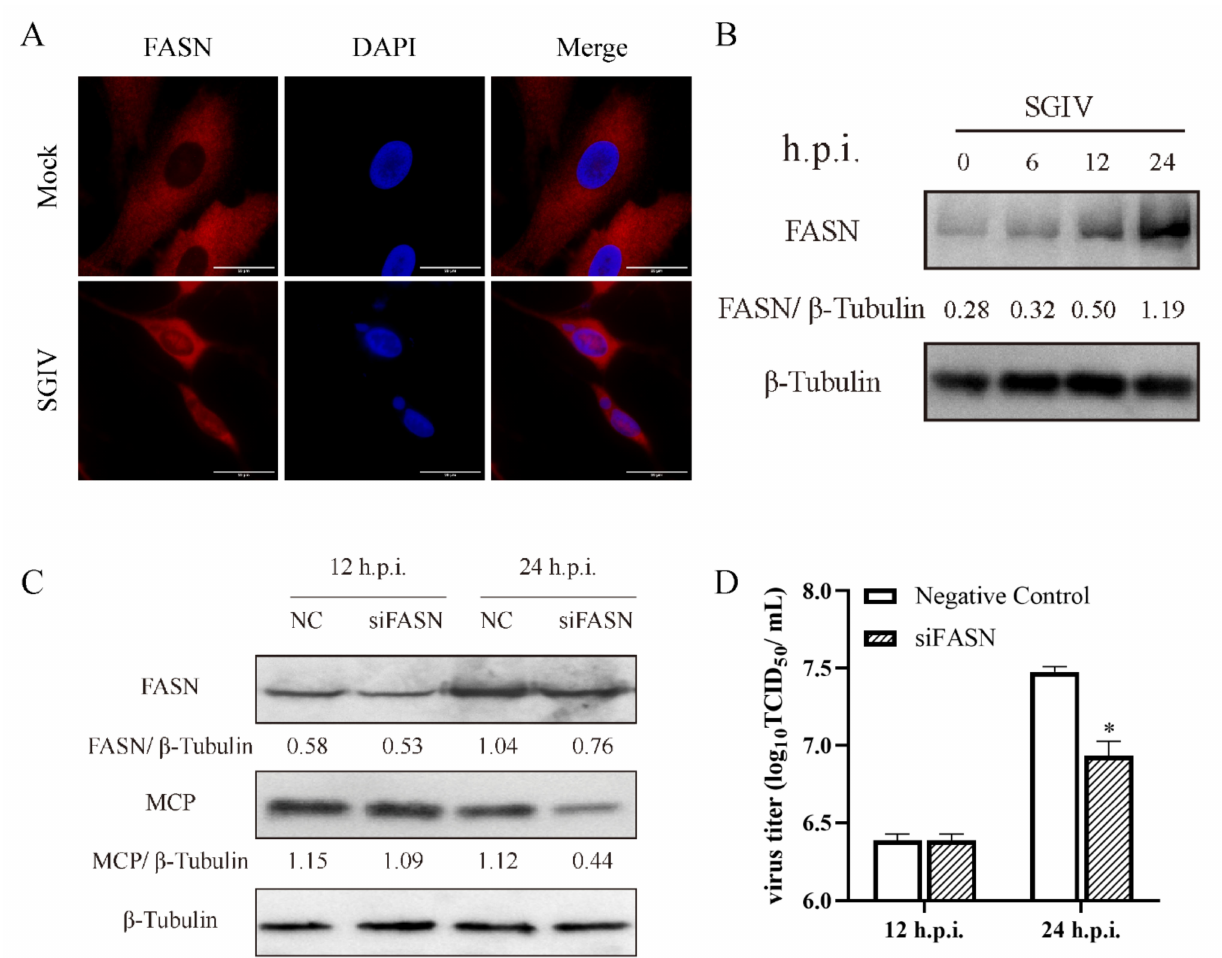
Figure 5. Roles of FASN during SGIV replication. Immune fluorescence detection of the FASN protein after treatment with mock and SGIV. Red fluorescence indicates FASN protein ( A ). Protein expression of FASN during SGIV infection ( B ). Effects of siRNA on SGIV MCP protein expression during SGIV infection ( C ). Effects of siRNA on SGIV TCID 50 during SGIV infection ( D ). n = 3, data are expressed as means ± SD, * indicates p <